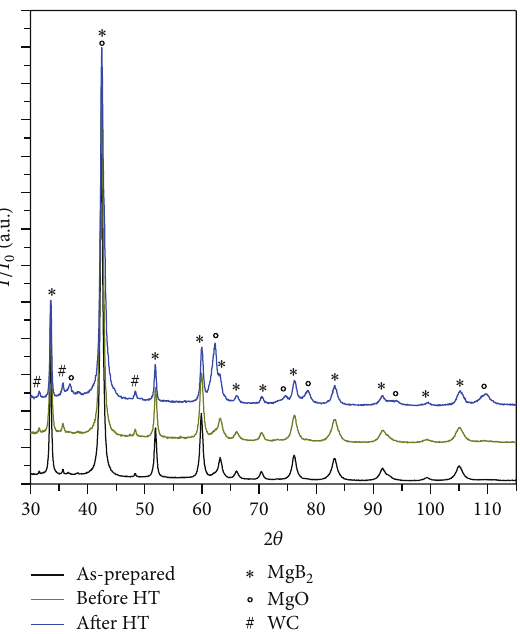
Figure 1: XRD patterns of the MgB 2 powders.